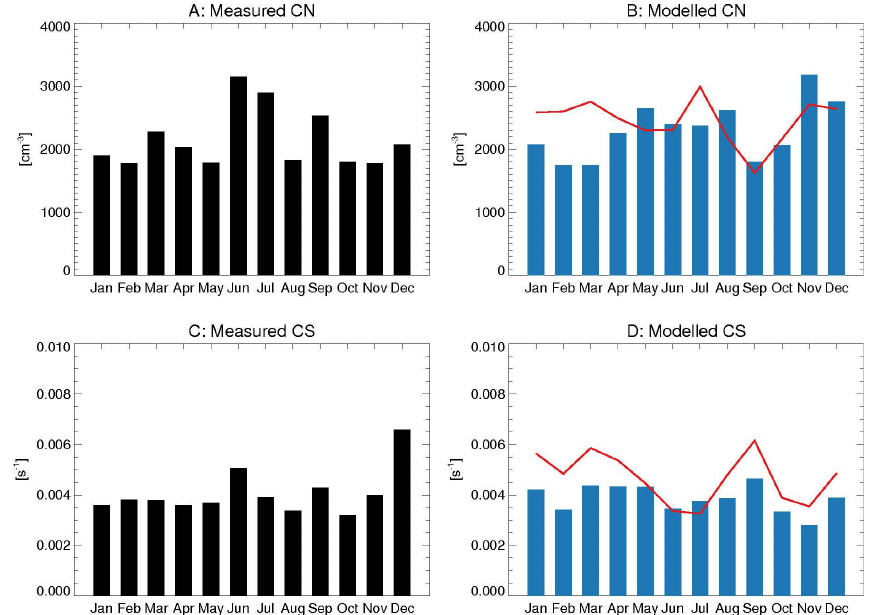
Fig. 5. (A) Monthly median concentration of measured 10–840nm particles; (B) Monthly median concentration of simulated 10–840nm particles; (C) Monthly median observed condensation sink; and (D) Monthly median simulated condensation sink. In this and in subsequent figures the bars in the right hand panels indicate the model results with kinetic sulphuric acid nucleation (Eq. 1) and the standard secondary organics scheme, and red lines correspond to results assuming both sulphuric acid and secondary organics nucleation (Eq. 2) and doubled secondary organics